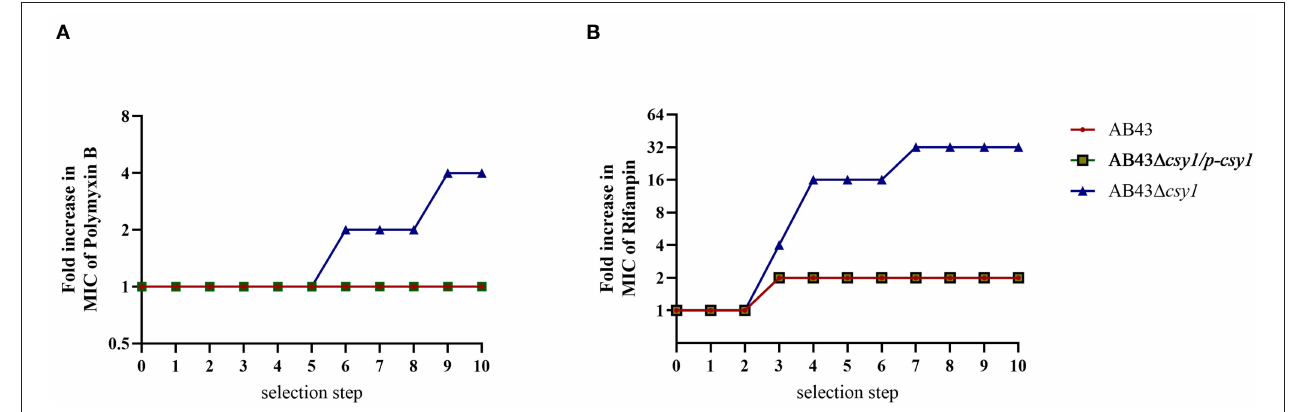
FIGURE 4 | Polymyxin B and rifampicin resistance gains during continuous passaging. (A) Polymyxin B; (B) Rifampicin.